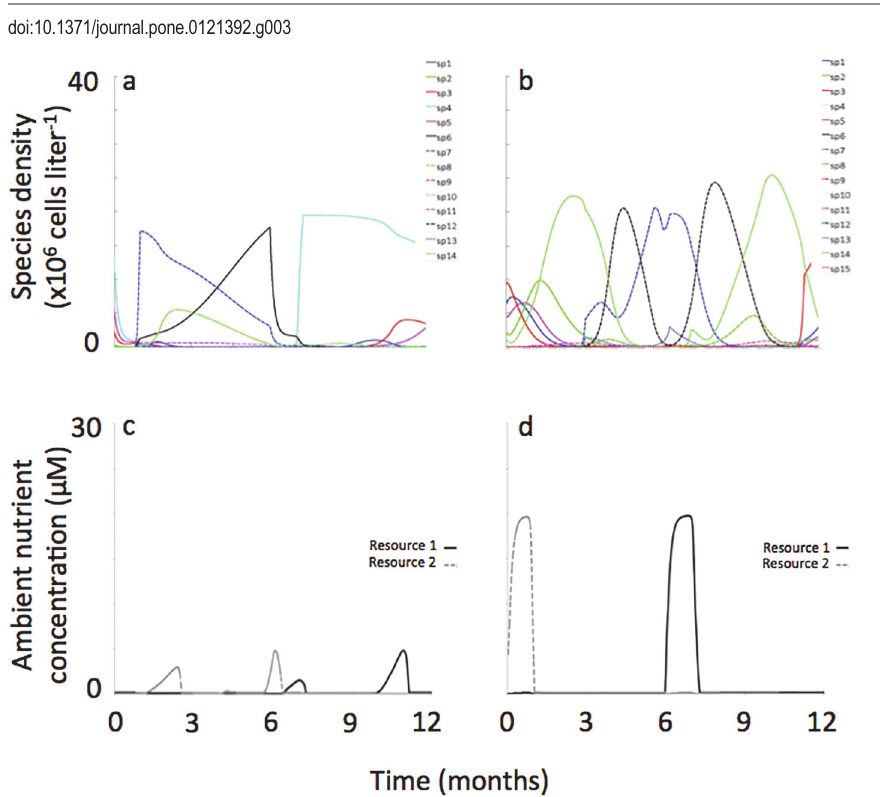
Fig 4. Representative phytoplankton population dynamics and ambient resource concentrations when reversals in the resource supply concentrations were sudden (a, c) and gradual (b, d). In these simulations there was no noise applied to the resource supply. Values of k S and Q S for phytoplankton populations are provided in Table